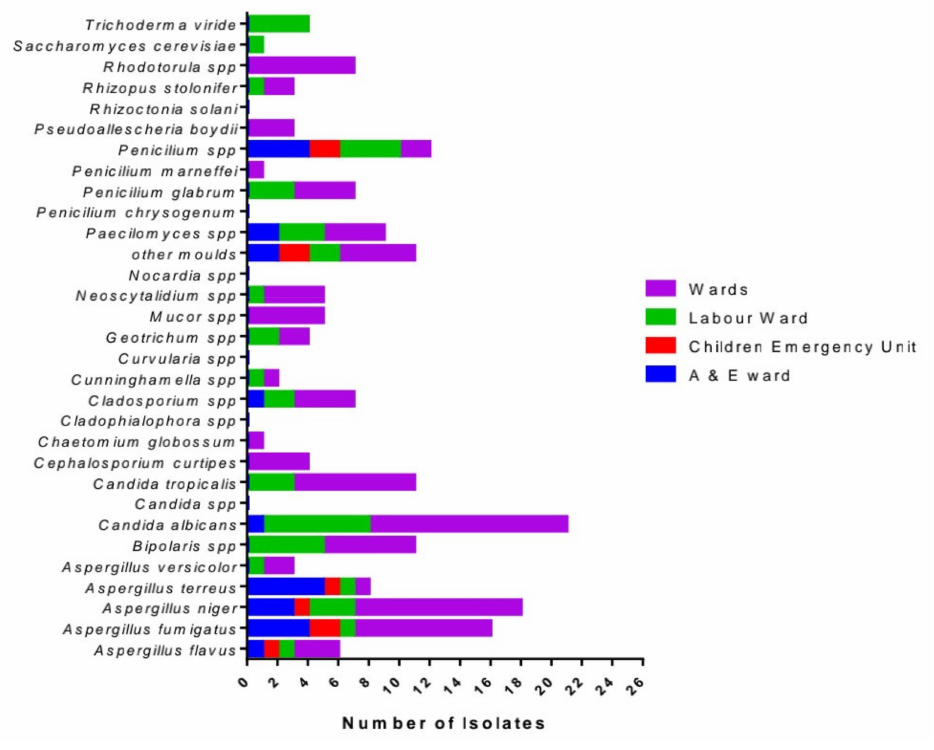
Figure 1. Distribution of isolates in water samples from low risk locations.